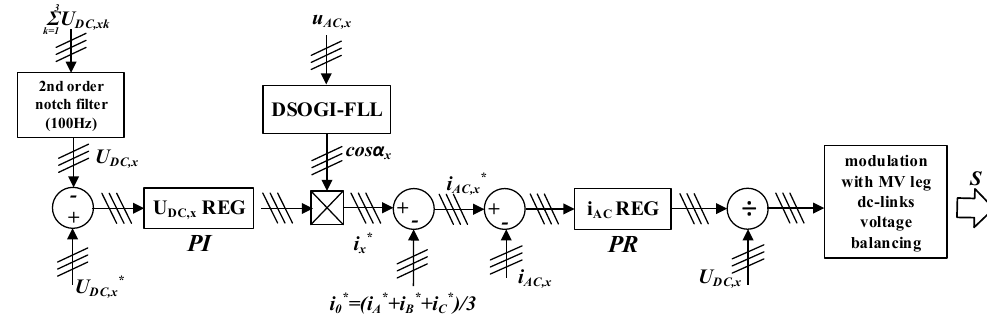
Figure 5. Scheme of chosen topology for ST’s MV-AC/MV-DC and MV-DC/LV-DC converters.